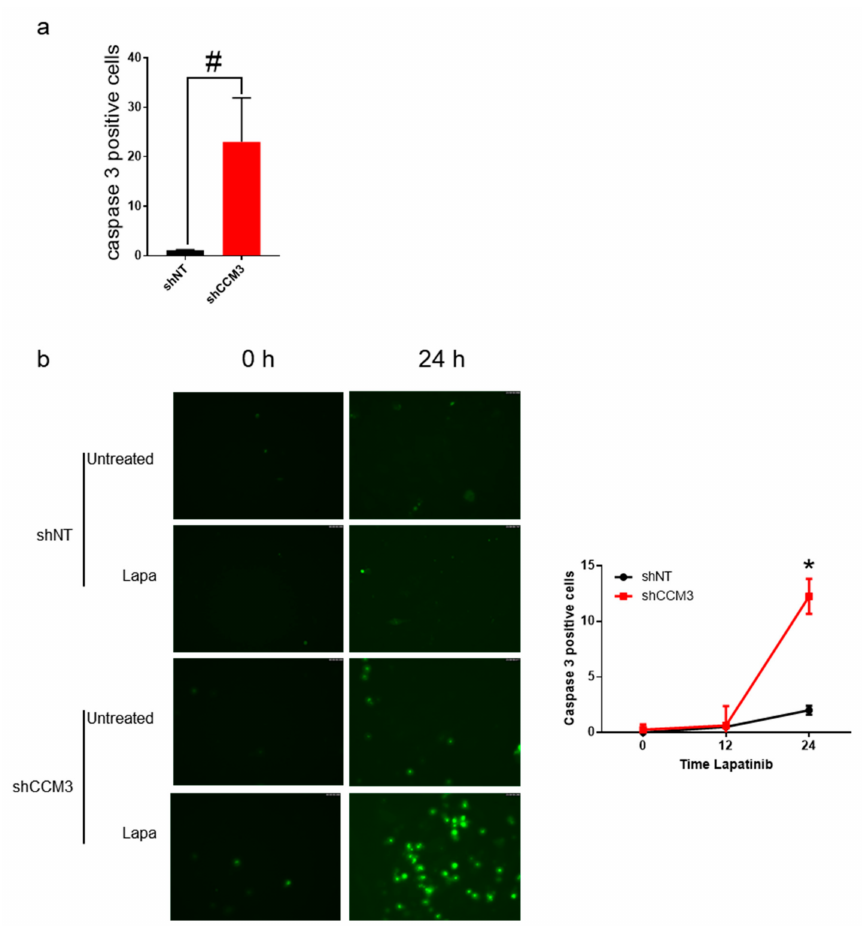
Figure 7. Deficiency of CCM3 makes endothelial cells more susceptible to inhibition of EGFR family receptors; ( a ) hCMEC / D3 cells transduced with shNT and shCCM3 shRNAs were treated with the EGFR family inhibitor Lapatinib for 24 h at 2 µ M, apoptotic cells were detected. The number of cells with activated caspase 3 / 7 are represented. # p = 0.07. ( b ) HuVECs transduced with shNT and shCCM3 shRNAs were treated with 2 µ M of the EGFR family inhibitor Lapatinib for 24 h and apoptotic cells were detected using the CellEvent ™ Caspase-3 / 7 Green Detection Reagent (left panel). Number of caspase 3 / 7 positive cells at the indicated times were counted (right panel) * p < 0.05 vs.